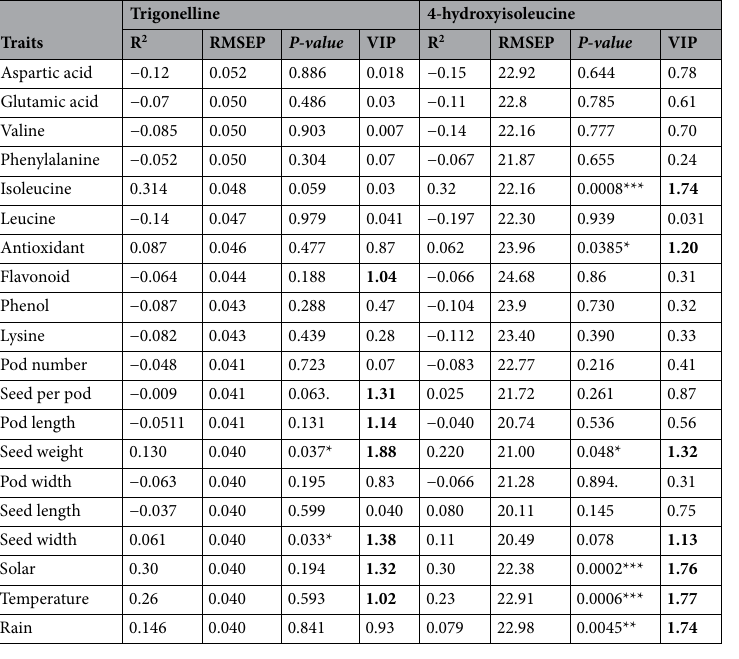
Table 4. Validation partial least square regression (PLSR) models for trigonelline and 4-hydroxy isoleucine. Variables importance in the projection (VIP) greater than one (bold) were used to select relevant latent variables. Root mean square errors (RMSEP) and R 2 were applied for cross-validation in PLSR